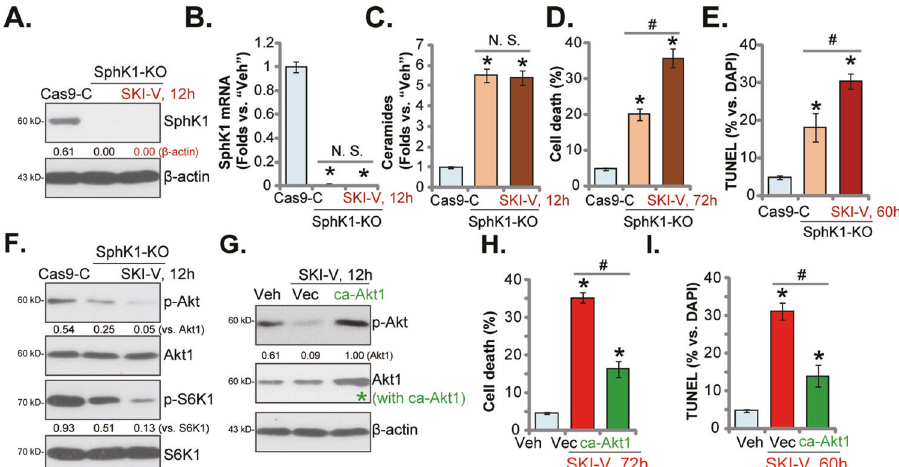
Fig. 5 Akt-mTOR inhibition in SKI-V-treated OS cells. The primary OS cells ( “ C1 ” ), stably expressing a CRISPR/Cas9-SphK1 KO construct ( “ SphK1-KO ” cells), were treated with or without 25 μ M of SKI-V, and cultured for applied time periods; control cells were stably expressing the control CRISPR/Cas9 vector ( “ Vec ” ); expression of listed proteins and mRNA were tested by western blotting ( A and F ) and qRT-PCR ( B ) assays. Cellular ceramide contents were examined ( C ); cell death and apoptosis were tested by trypan blue staining ( D ) and nuclear TUNEL staining assays ( E ), respectively, with results quanti fi ed. The primary OS cells ( “ C1 ” ), stably expressing the constitutively-active Akt1 (ca-Akt1, S473D) or empty vector ( “ Vec ” ) were treated with 25 μ M of SKI-V for applied time periods; expression of listed proteins was tested by Western blotting assays ( G ). Cell death (Trypan blue staining assays, H ) and apoptosis (by measuring TUNEL-stained nuclei ratio, I ) were tested. “ Veh ” stands for the vehicle control. Data were presented as mean ± standard deviation (SD, n = 5). * P < 0.05 vs. “ Cas9-C ” / “ Veh ” cells. # P < 0.05 ( D , E , H and I ). “ N. S. ” stands for non-statistical difference ( P > 0.05) ( B and C ). Experiments in this Figure were repeated fi ve times with similar results obtained.